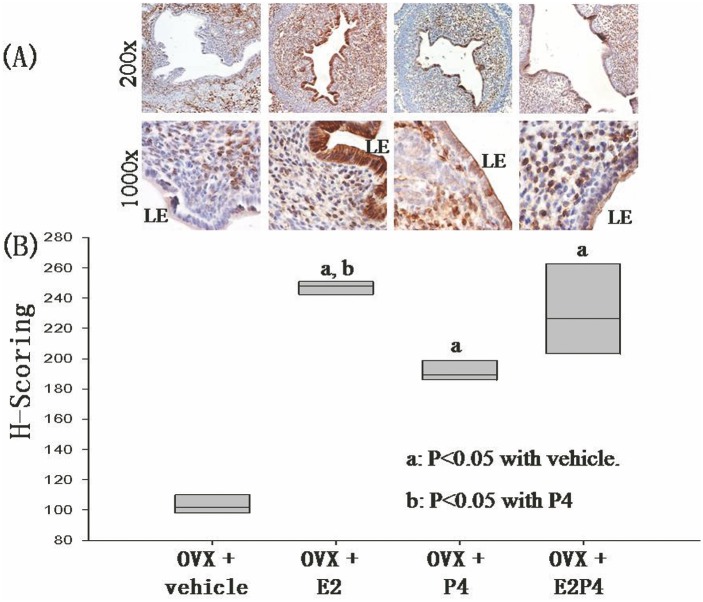
Effects of estradiol and progesterone on the expression of Axna2 in endometrial luminal epithelium of ovariectomized mice.
(A) The expression of Axna2 was increased by estradiol (E2), progesterone (P4) and their combined (E2P4) treatment. E2 had the most potent effect. (B) H-Scoring of immunohistochemical staining. a P<0.05 with control (ctrl), b P<0.05 with P4.